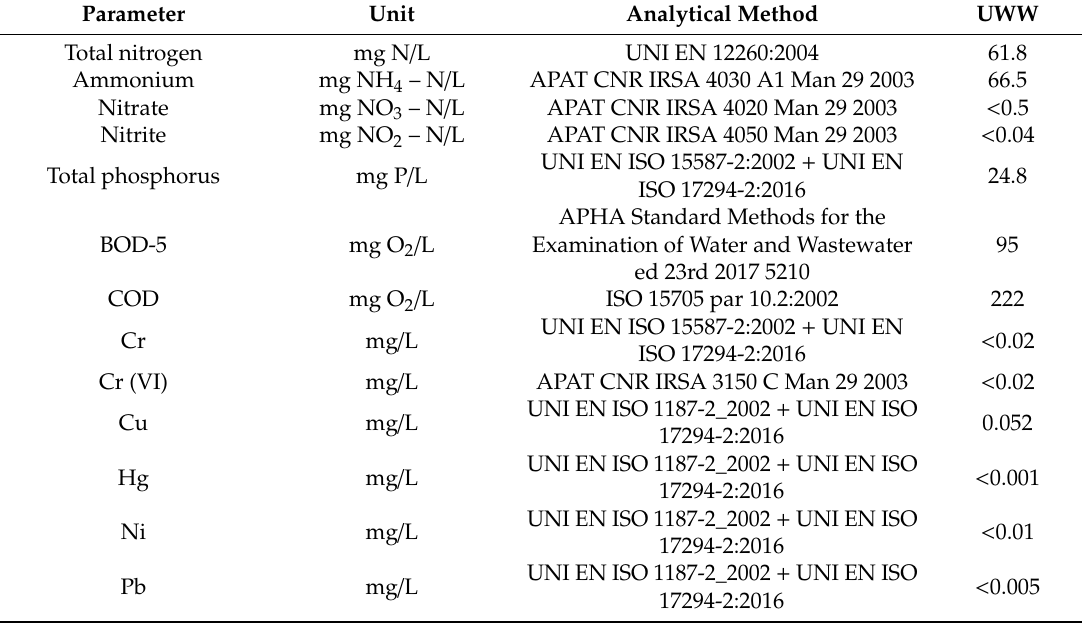
Table 1. Characterization of the UWW and analytical methods employed for the analyses.